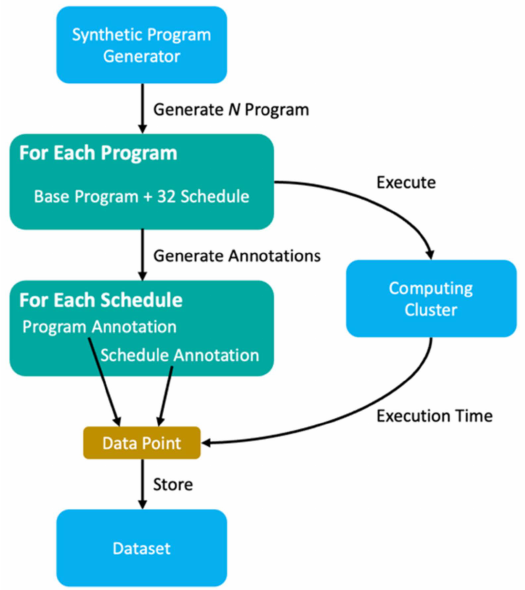
Figure 10. Workflow of proposed method.